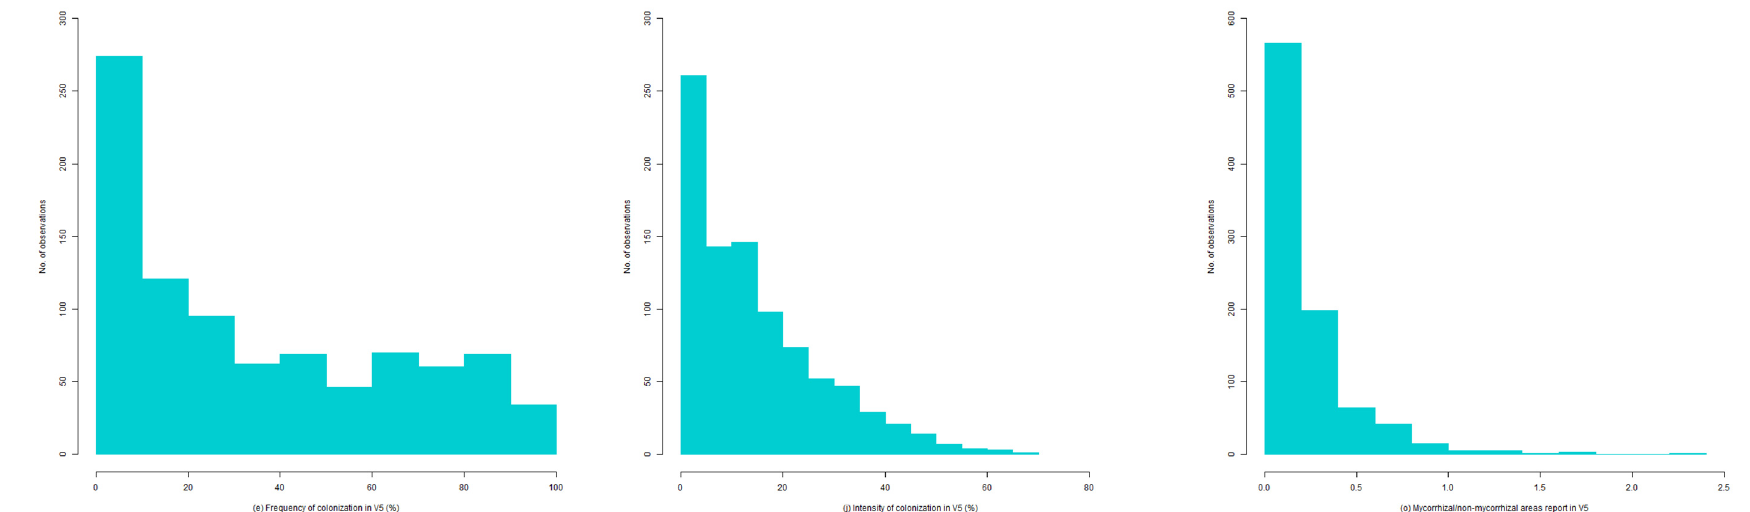
Figure 1. Histograms of colonization parameters F. rubra roots for each experimental variant: ( a – e ) colonization frequency (%); ( f – j ) colonization intensity (%); ( k – o ) mycorrhizal/non-mycorrhizal report. Treatments V1–V5: V1 (control variant)—untreated; V2—organic (manure) treatment—10 t ha − 1 manure; V3—low-mineral organic treatment—10 t ha − 1 manure + 50 N 25 P 2 O 5 25 K 2 O; V4—mineral treatment—100 N 50 P 2 O 5 50 K 2 O; V5—high-mineral organic treatment—10 t ha − 1 manure + 100 N 50 P 2 O 5 50 K 2 O.